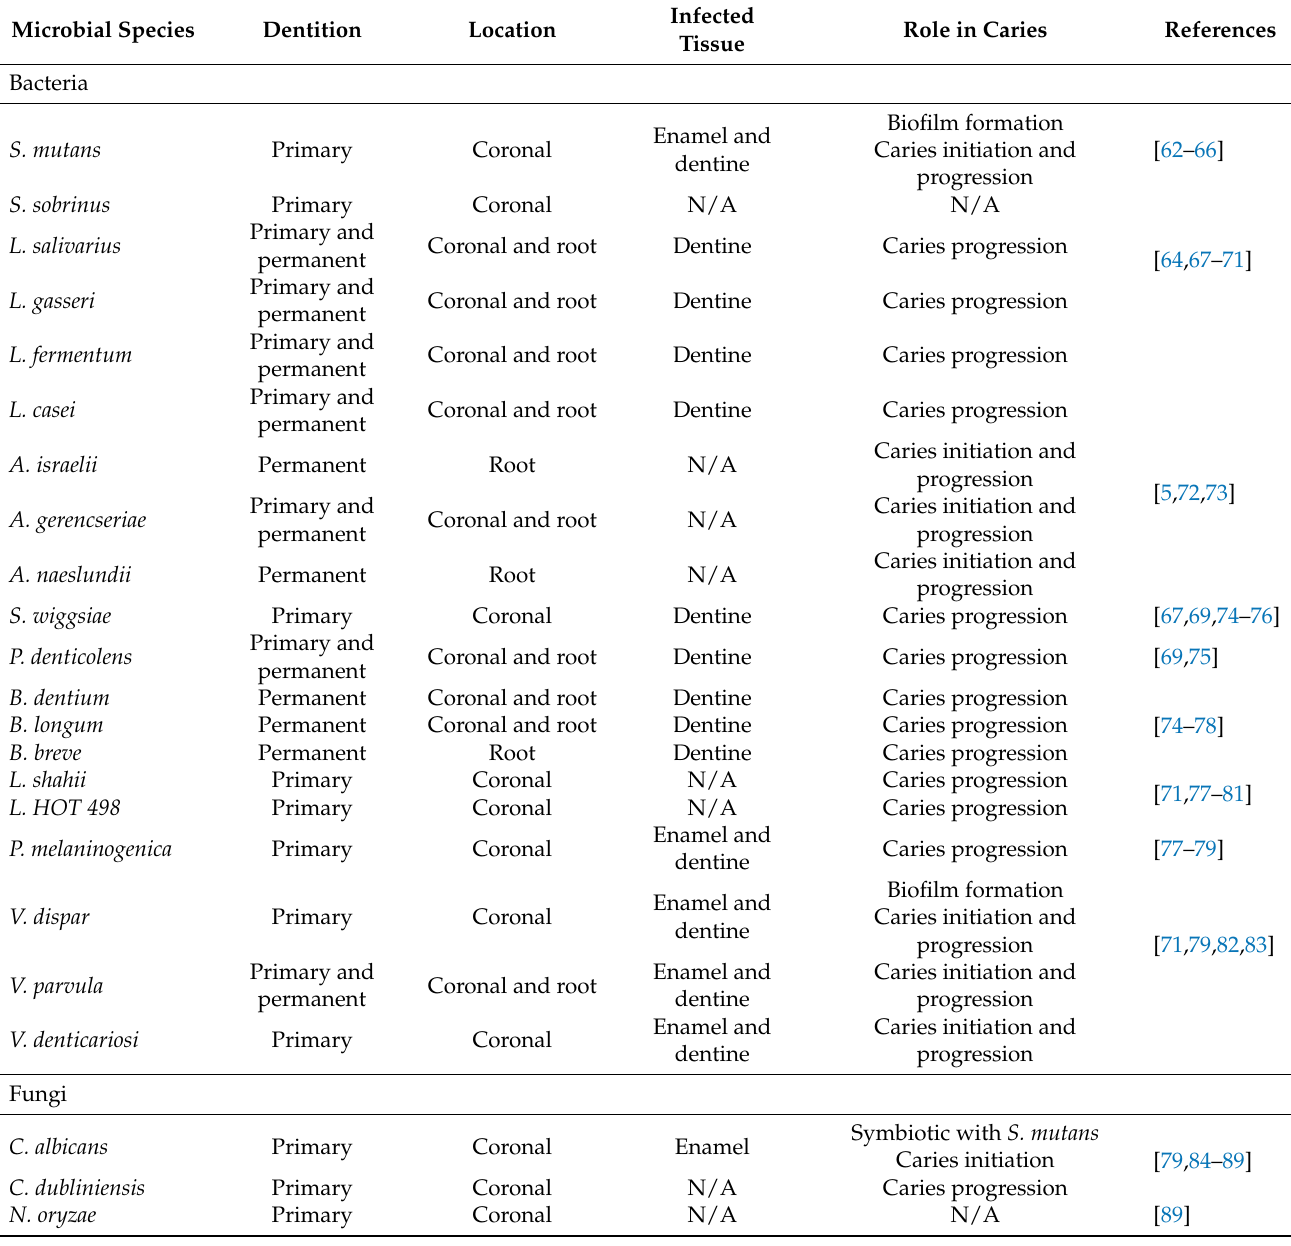
Table 1. Microbial species related to